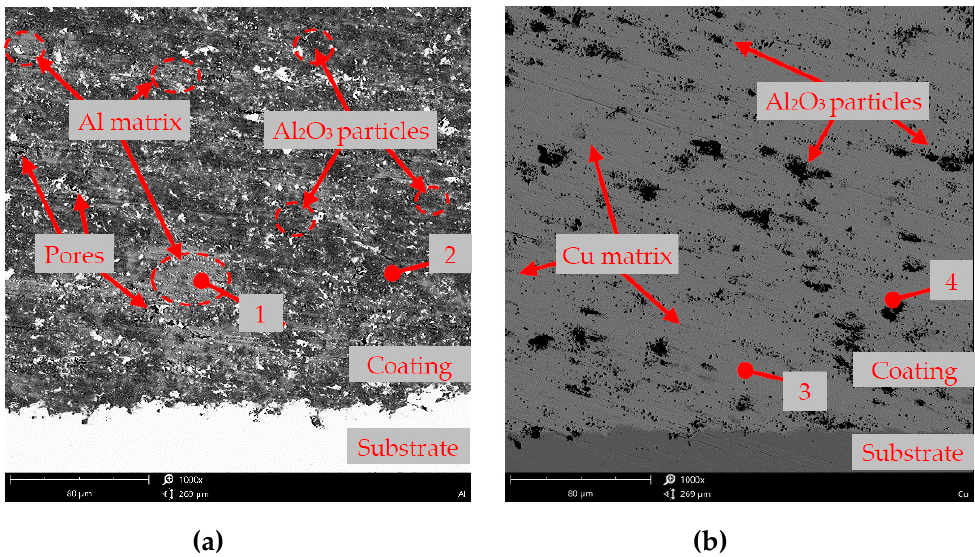
Figure 2. Surface morphology of composites: ( a ) As-sprayed Al/Al 2 O 3 ; ( b ) as-sprayed Cu/Al 2 O 3 ( c ) ground Al/Al 2 O 3 and ( d ) ground Cu/Al 2 O 3 , macrophoto and SEM-BSE.